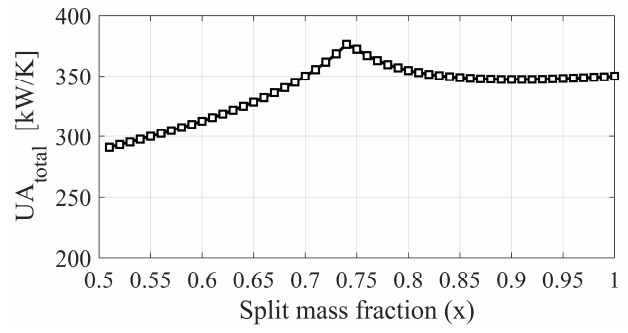
Figure 13. Total heat transfer area coefficient ( (cid:1847)(cid:1827) (cid:3021)(cid:3042)(cid:3047)(cid:3028)(cid:3039) ) vs. split mass fraction ( x ) at (cid:1846) (cid:2875) = 700 (cid:3042) (cid:1829)